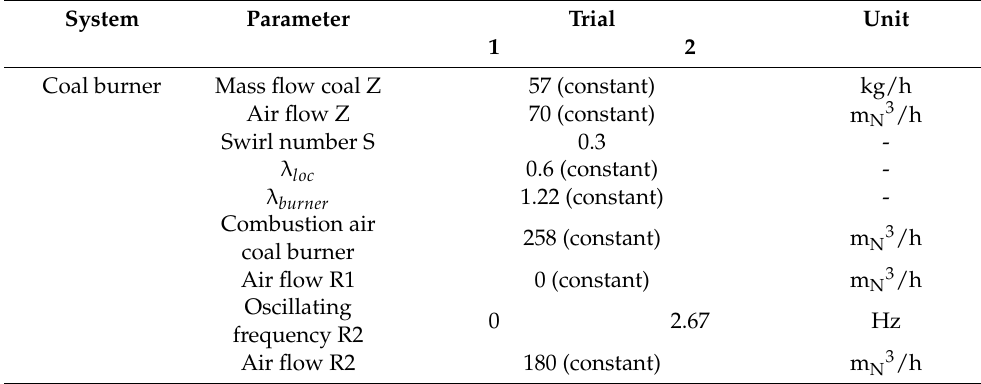
Table 4. Trial plan Campaign B investigation of the reproducibility of previous test settings.